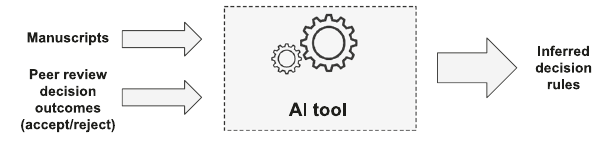
Fig. 2 Schematic illustration of the training approach. Manuscripts and peer review decision outcomes are inputs of the AI tool to infer